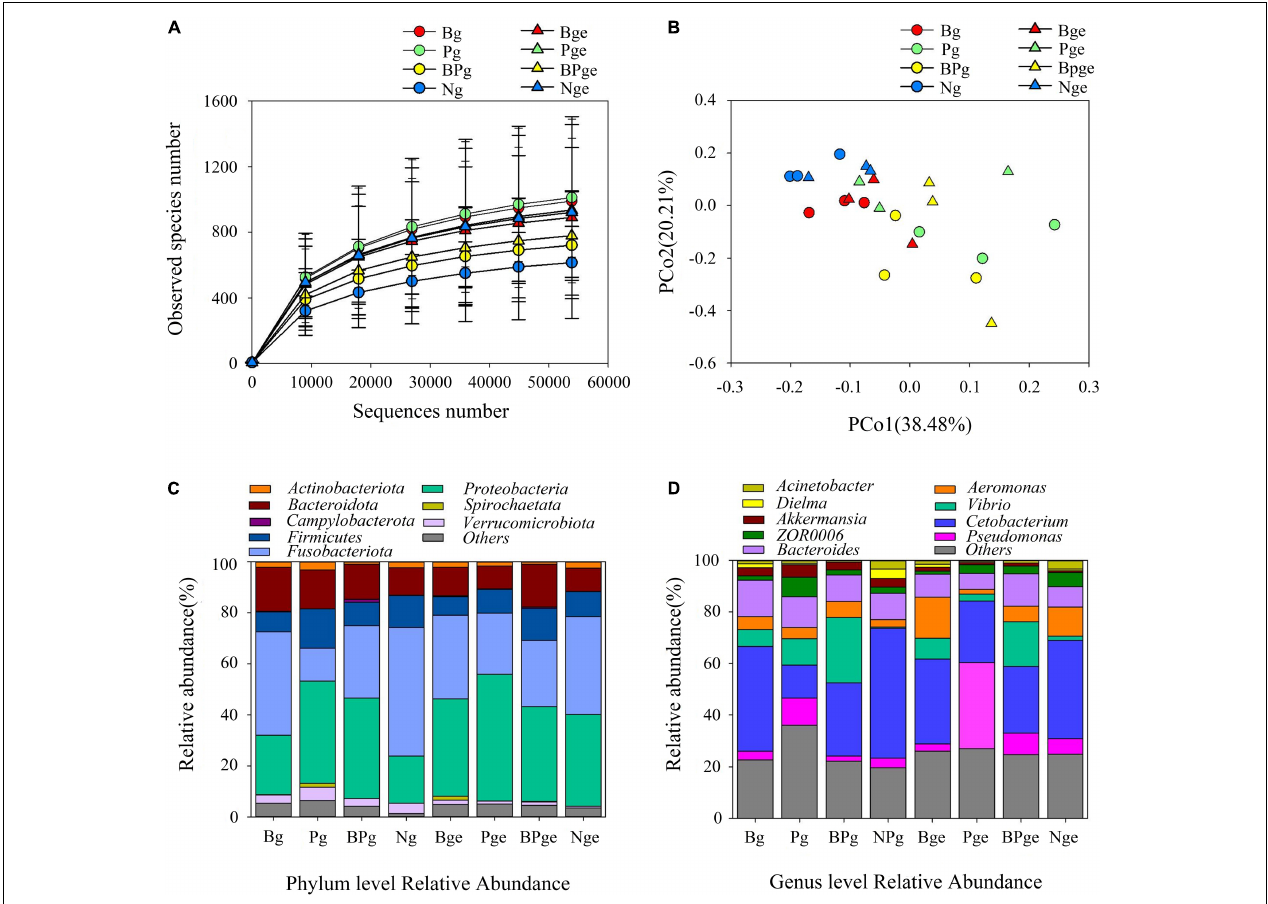
FIGURE 10 | The effects of A. hydrophila challenge and phage therapy on the composition of the gut microbiota. (A) Rarefaction curves based on the observed species of bacteria. (B) PCoA of the bacteria community based on Bray-Curtis distance. (C) Bacterial taxonomic profiling at the phylum level. (D) Bacterial taxonomic profiling at the genus